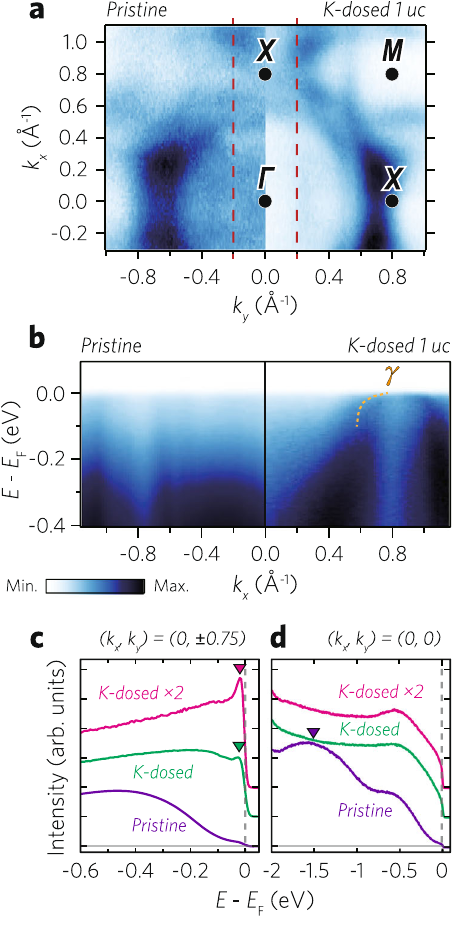
Fig. 5 Incoherent-to-coherent crossover in monolayer SRO. a FS maps of pristine and K-dosed monolayer SROs measured at 10 K. b Band dispersions of pristine and K-dosed monolayer SROs along the k y = − 0.2 ∘ A − 1 line (red dotted line in a ). c , d EDCs from pristine and K-dosed monolayer SRO fi lms near the X and Γ points normalized by E = − 0.6 and − 2 eV, respectively. With K dosing, a quasi-particle peak reappears near the Fermi level, while the hump peak in the high-binding energy region disappears, as marked by inverted triangles. 'K-dosed×2' indicates twice the dosing amount of